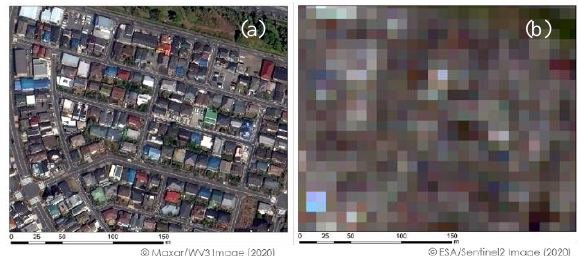
Figure 2 . (a) WV3 image taken on 2020/04/02 with ground resolution (GR) 0.3m (b) respective S2 image taken at same location on 2020/04/02 with 10.0m